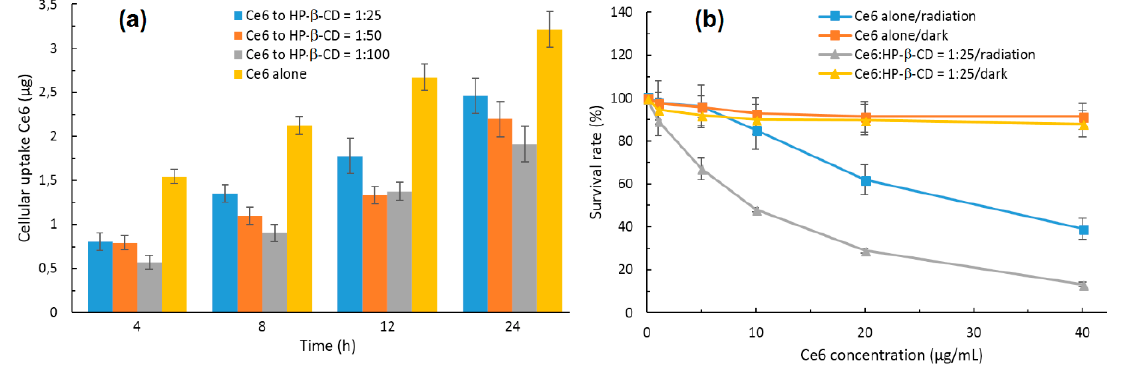
Figure 11. ( a ) In vitro cellular uptake of the Ce6-HP- β -CD inclusion complex by oral squamous carcinoma (OSC) cells for different Ce6 to HP- β -CD ratios and ( b ) phototoxicity of optimized inclusion complex and control formulations against OSC cells. Adapted from Paul; Heng; Chan [126].